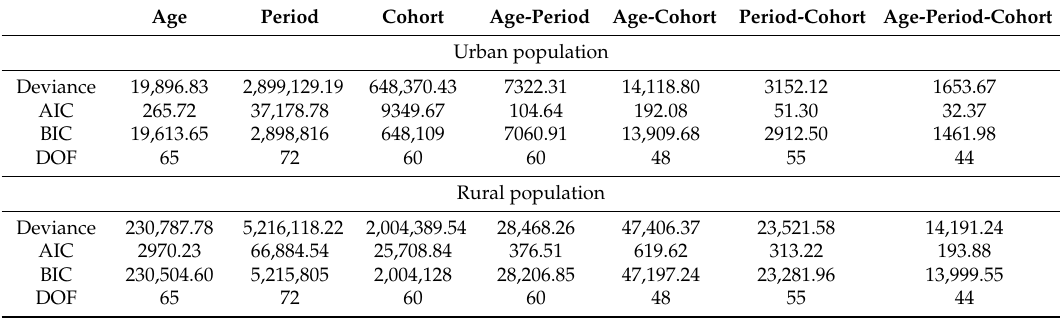
Table 1. Goodness-of-fit statistics for age-period-cohort log linear models of China ischemic heart disease (IHD) mortality rates between 1987 and 2013.